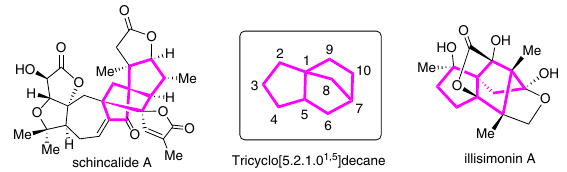
Fig. 1 Representative examples of bioactive compounds. Bridged tricyclo [5.2.1.0 1,5 ]decane scaffolds are structural cores in many natural products.